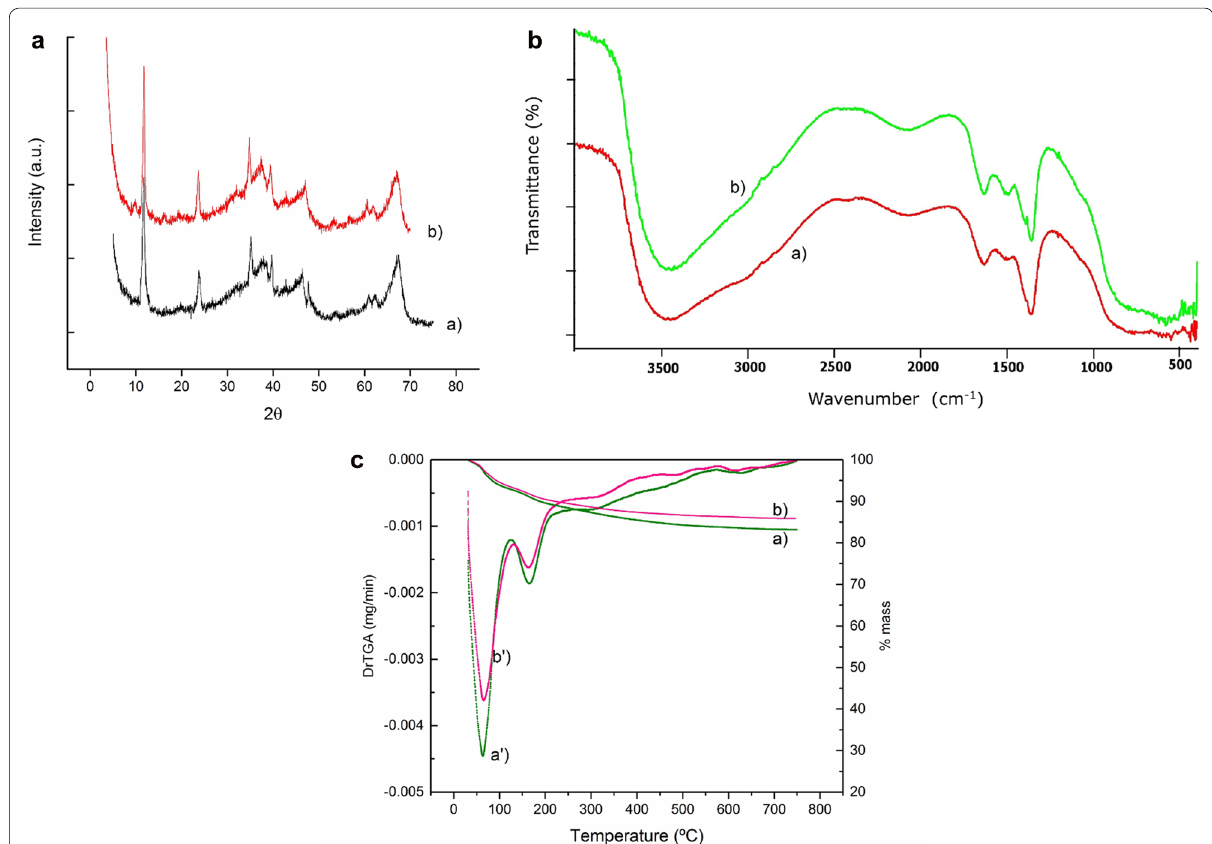
Fig. 12 a XRD spectra; b FTIR spectra and c thermogravimetric analysis for 0.5 Zn/Mg catalyst, a) fresh and b) after 4 reaction